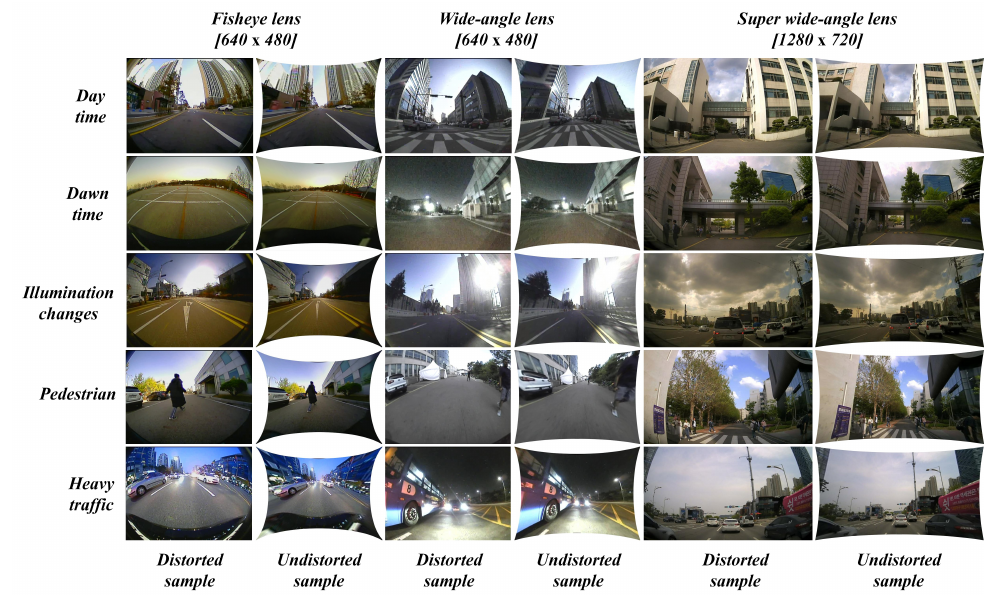
Figure 18. Performance of proposed algorithm on different camera acquisitions in various real-time